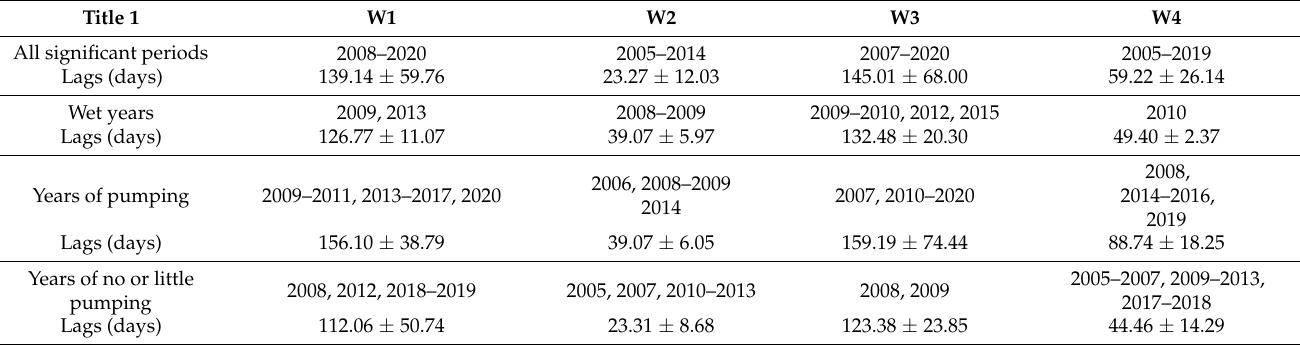
Table 4. Time lags from the cross wavelet spectra between rainfall and GWLs (period of 365 days band).